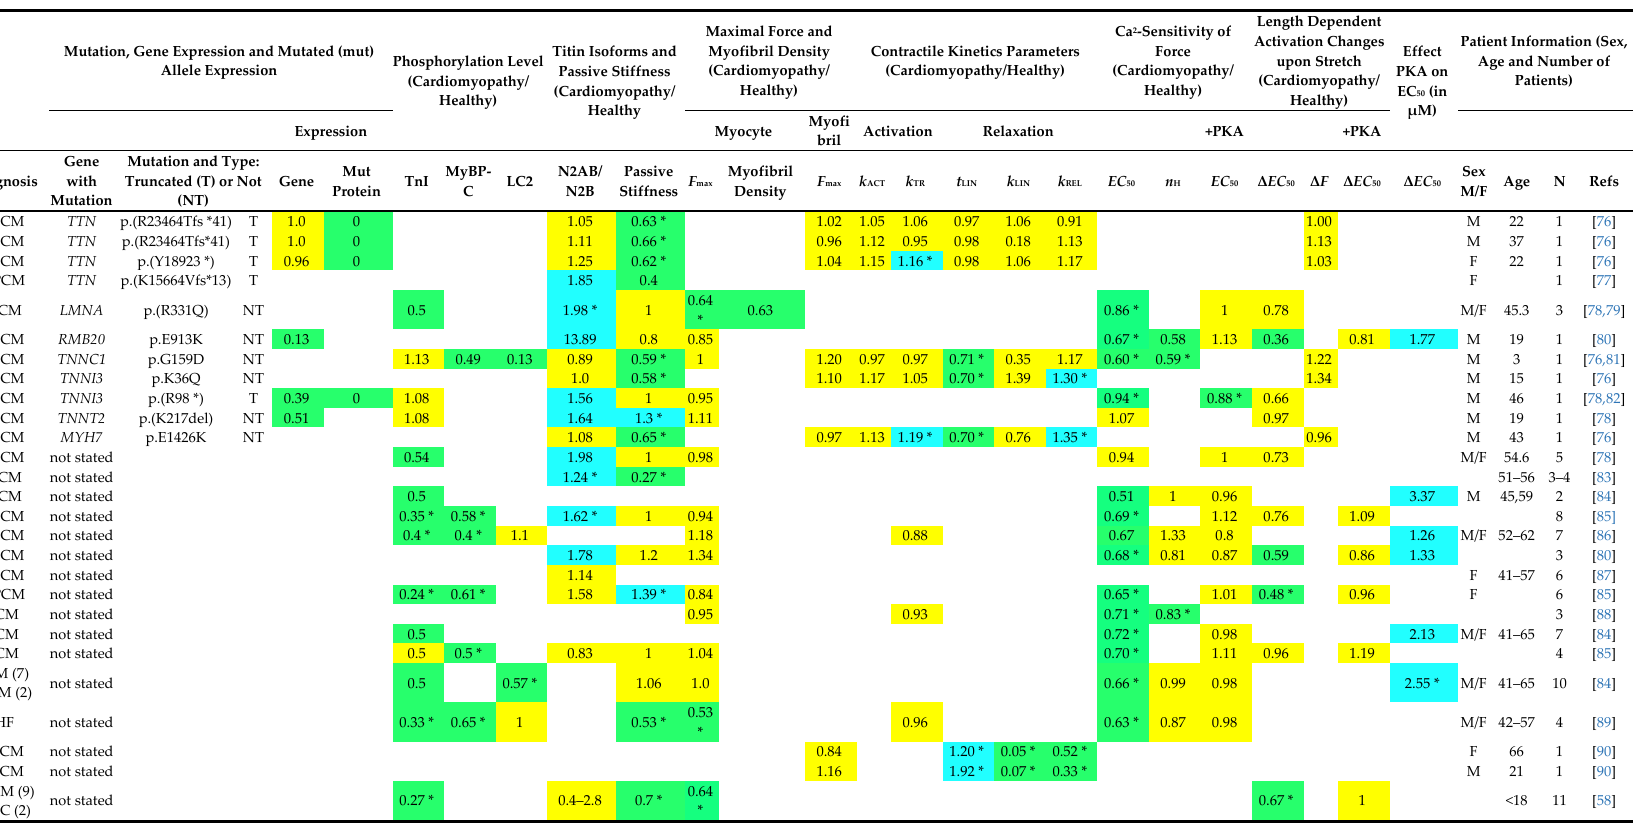
The value changes were normalized to healthy control hearts (Cardiomyopathy/Healthy) if not otherwise specified. The parameters of length dependent activation are shown as a difference in EC 50 and F max between long and short sarcomere length. Passive stiffness was evaluated as a Young’s modulus or as a passive tension generated by muscle at stretch. In some cases, approximate values are given. * p < 0.05. PPCM—peripartum cardiomyopathy, ICM—ischemic cardiomyopathy, RCM—restrictive cardiomyopathy, HF—heart failure, IDCM—idiopathic DCM, fDCM-familial DCM, IRCM—idiopathic restrictive cardiomyopathy. The table cells are highlighted according to the value changes compared to control: yellow—no changes, green—the value decreased, blue—the value increased.